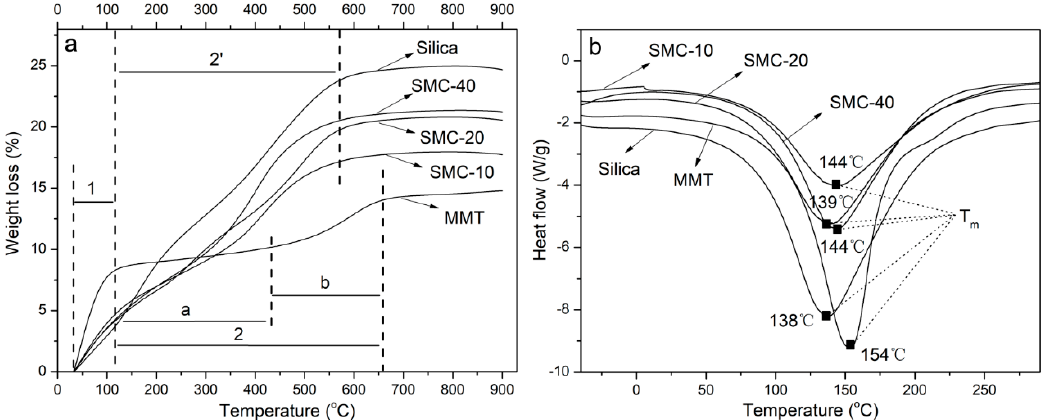
Figure 3. Thermogravimetric analysis (TGA) curves ( a ) and differential scanning calorimetric analysis (DSC) curves ( b ) of MMT, silica and silica/MMT nanocomposites.